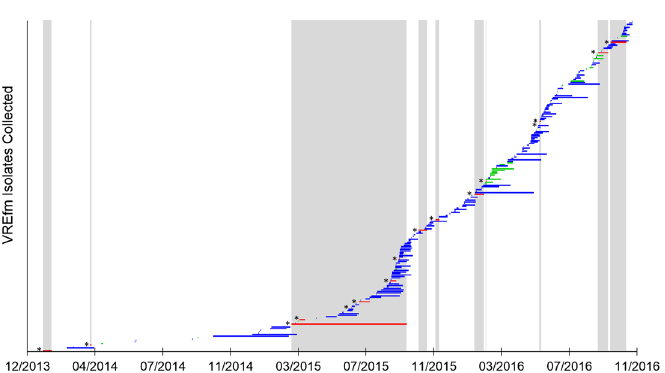
Figure 2. Temporal distribution of vancomycin-resistant Enterococcus faecium (VREfm) isolates ( n = 222) collected from patients at the Royal Hobart Hospital from 2014–2016. Each horizontal bar represents the period of time between patient hospital admission and VREfm sample collection. The selection criteria of VREfm isolates for whole-genome sequencing were based on the temporal overlap (vertical silver columns) of clinical isolates (red bars with * ) ( n = 16) with vanB screening VREfm isolates (blue bars). Also included in this study were VREfm isolates that tested positive for the vanA locus (green bars) ( n =